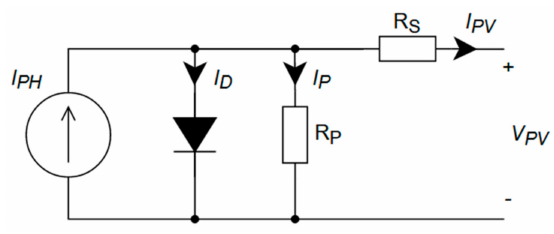
Figure 4. Single-diode equivalent circuit in a solar cell.